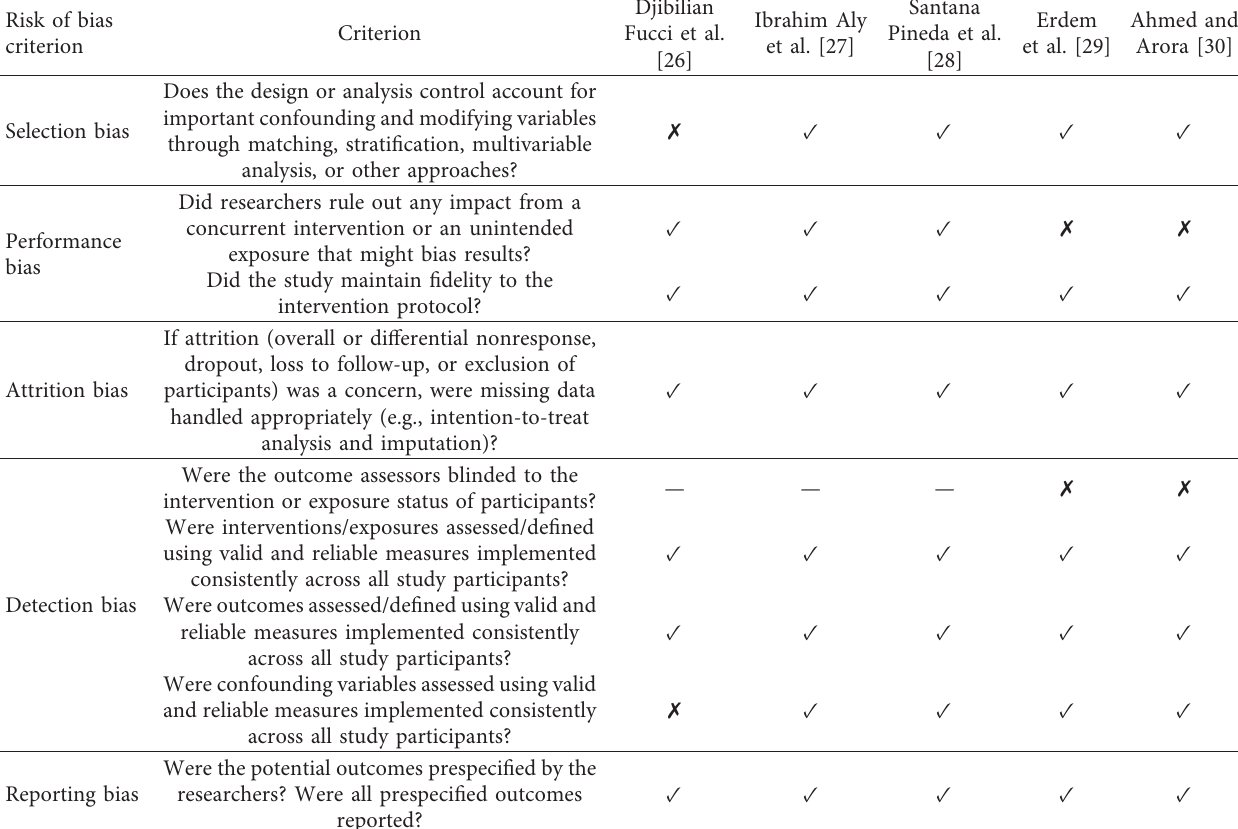
Table 4: Evaluation of bias for nonrandomized